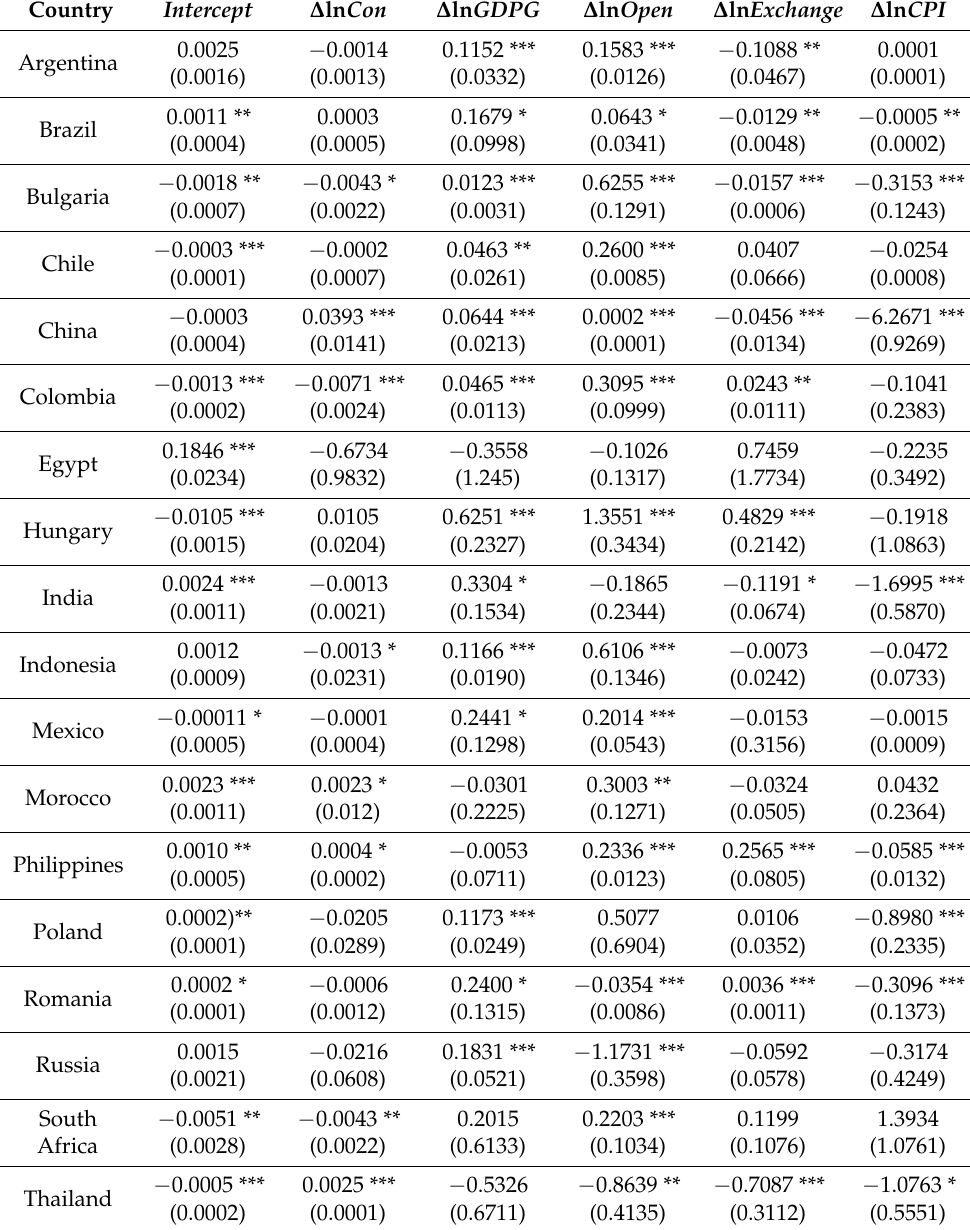
Table 9. Estimation results of the contagion effect on FDI inflows in emerging